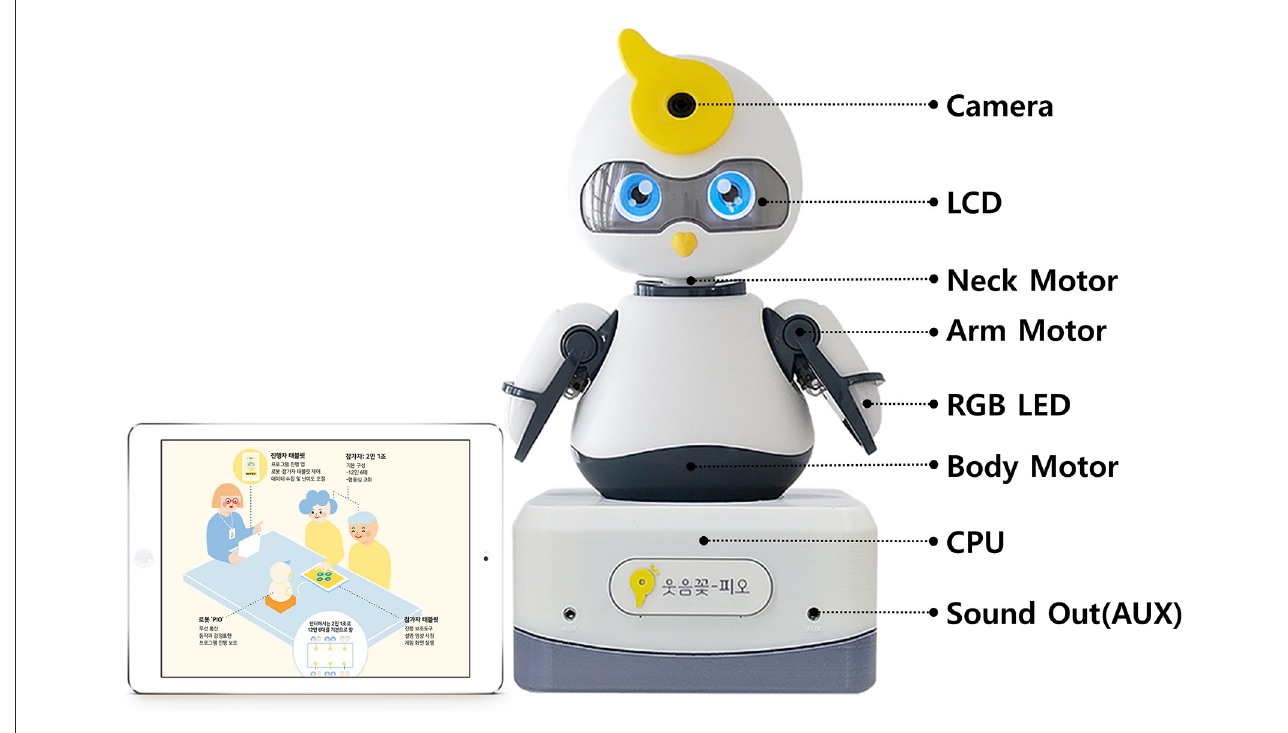
FIGURE2 Social robot PIO (Version